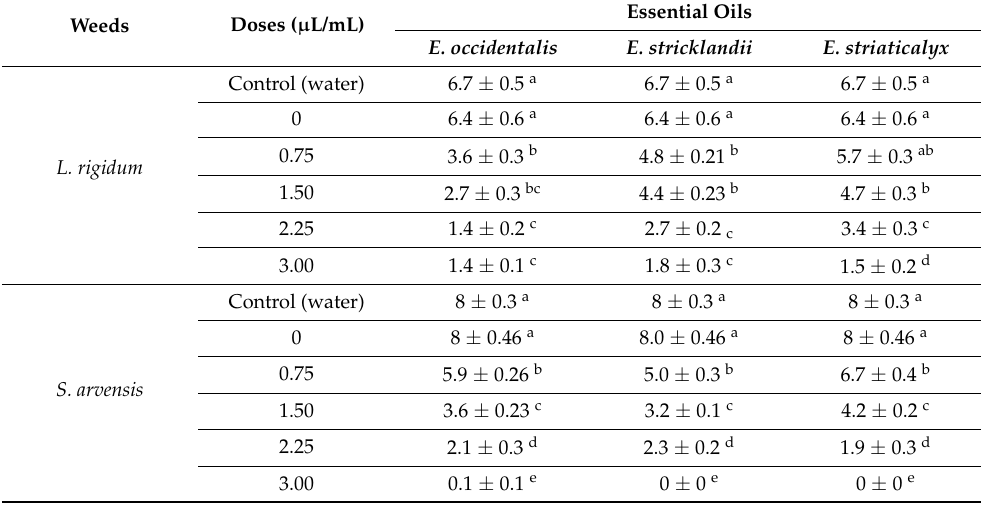
Table 3. Inhibitory effect of the EOs on shoot growth (cm) of Lolium rigidum , Sinapis arvensis and Trifolium campestre . Weeds Doses ( µ